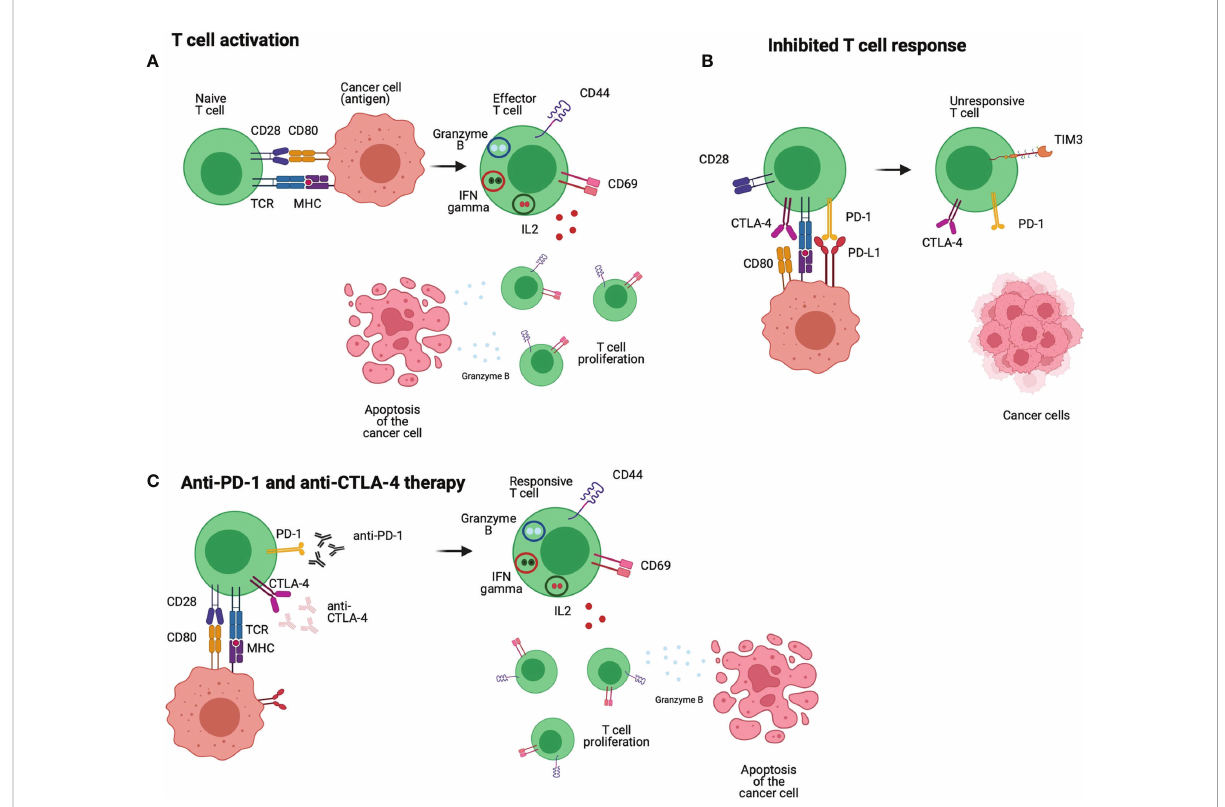
FIGURE 3 Anti-PD-1 and anti-CTLA-4 immunotherapies: T cells receive different stimulations that lead to an effective response, the fi rst comes from the interaction between TCR and MHC, but co-stimulation is also required such as the interaction of CD28 and CD80/86. The interaction between those molecules lead to positive signal and differentiation of T cells into a proliferative and responsive population (A) . In HNSCC patients, T cells express inhibitory molecules such as PD-1 that interacts with PD-L1 leading to a negative signal to the T cells. CTLA-4 is highly expressed in HNSCC T cells, and it interacts with CD80/CD86 blocking co-stimulation signals to the T cell. Therefore, the T cell is non proliferative and unresponsive (B) . Anti-PD-1 and anti-CTLA-4 are used to block the inhibitory molecules PD-1 and CTLA-4 and avoid the inhibitory signals received by the T cell. In this case, the T cell receives positive stimulatory and co-stimulatory signals and can exert their effector function to eliminate tumour cells (C) . Figure generated using Biorender